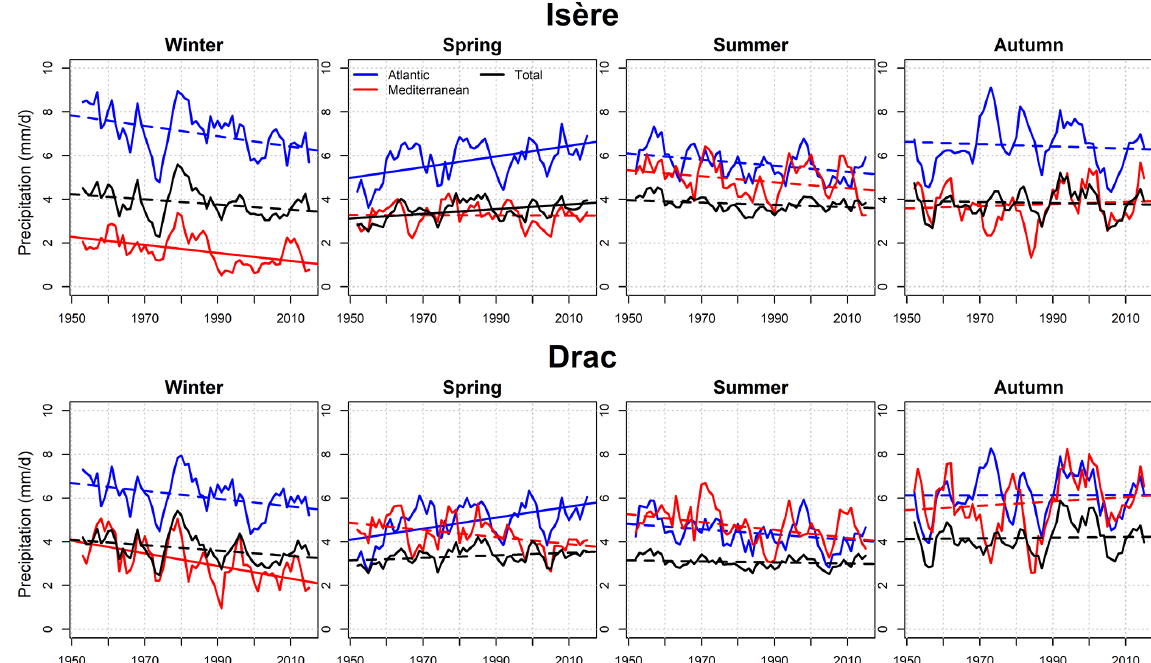
Figure 9. Evolution of seasonal precipitation (mmd − 1 ) for the Isère River catchment (top) and the Drac River catchment (bottom) over the period 1950–2017. For Atlantic and Mediterranean circulations, the seasonal precipitation is normalized by the number of days associated with the given influence. A running average of 5 years is applied to allow a clearer visualization. Non-significant trends are represented by dotted lines. The trend is considered as significant if the p value of the Student test is lower than 5%.